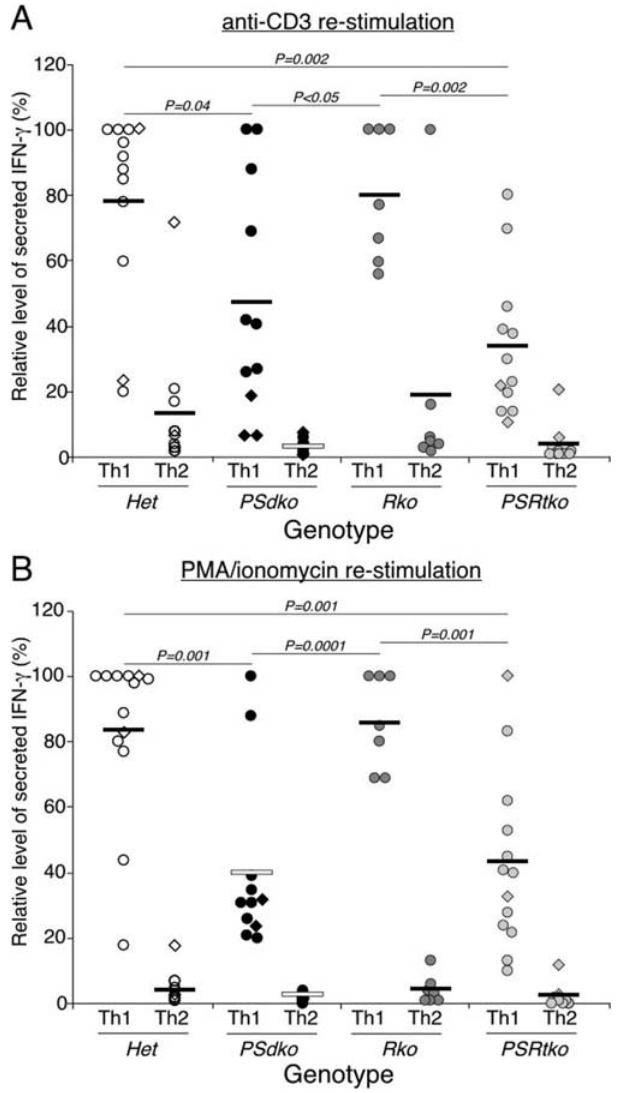
Figure 5. RBP-J-independent function of presenilin is required for optimal IFN- c secretion from differentiated Th1 cells. (A, B) Impaired IFN c cytokine production by PS1/PS2-deficient T cells is not rescued by the compound loss of RBP-J. The experiments were conducted as described in Figure 4 except that the supernatant was harvested for ELISA analyses. Each data point indicates individual mouse and is presented as the relative level of IFN- c secretion. This value is determined by calculating the percent of IFN- c secretion from individual mouse over the maximum level attained in each separate experiment (see Materials and Methods for details). The P value was determined by two-tailed paired t test.